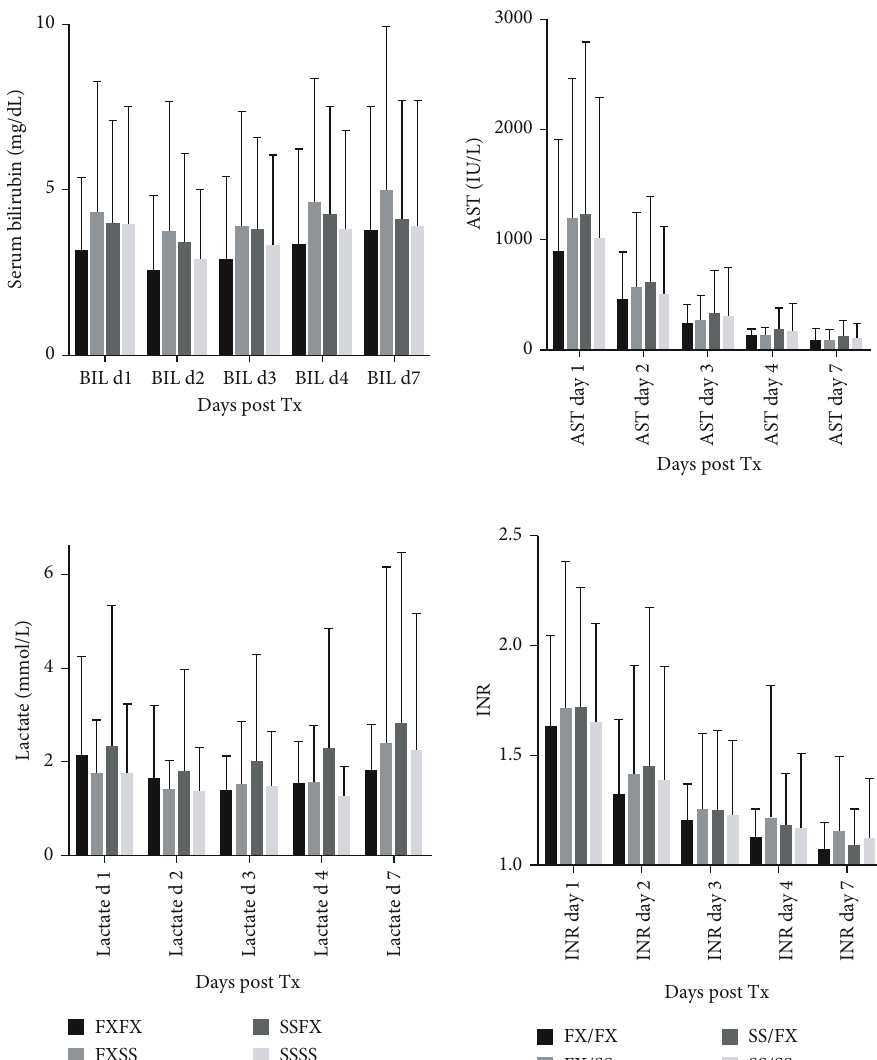
Figure 5: Week 1 liver function by 4 major donor/recipient C3 combinations. Liver function at days 1-7 posttransplant in liver transplant recipients ( n = 348 ) classi fi ed according to C3 donor/recipient